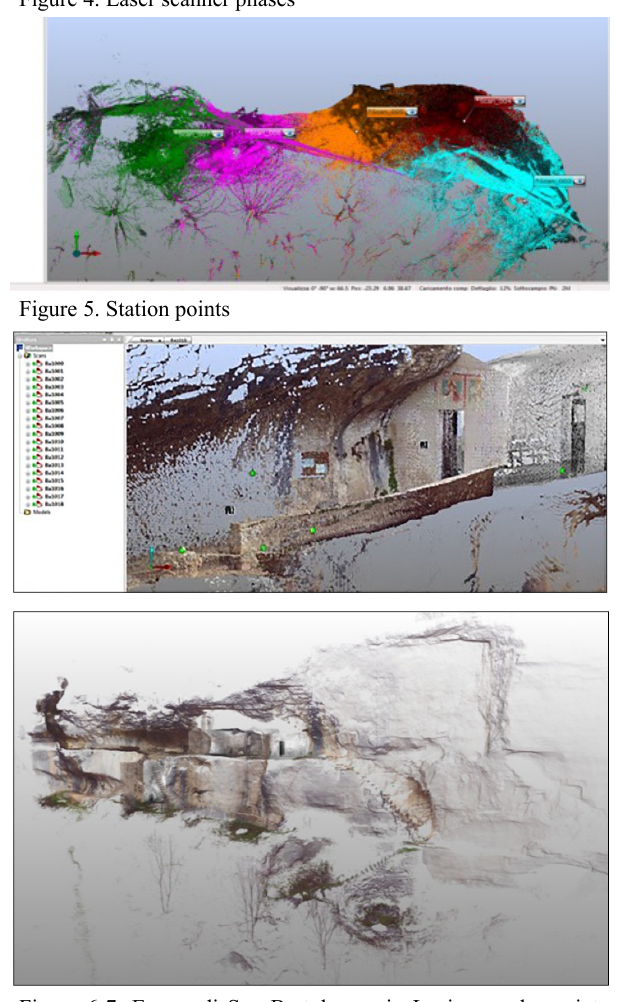
Figure 6-7. Eremo di San Bartolomeo in Legio, regular point